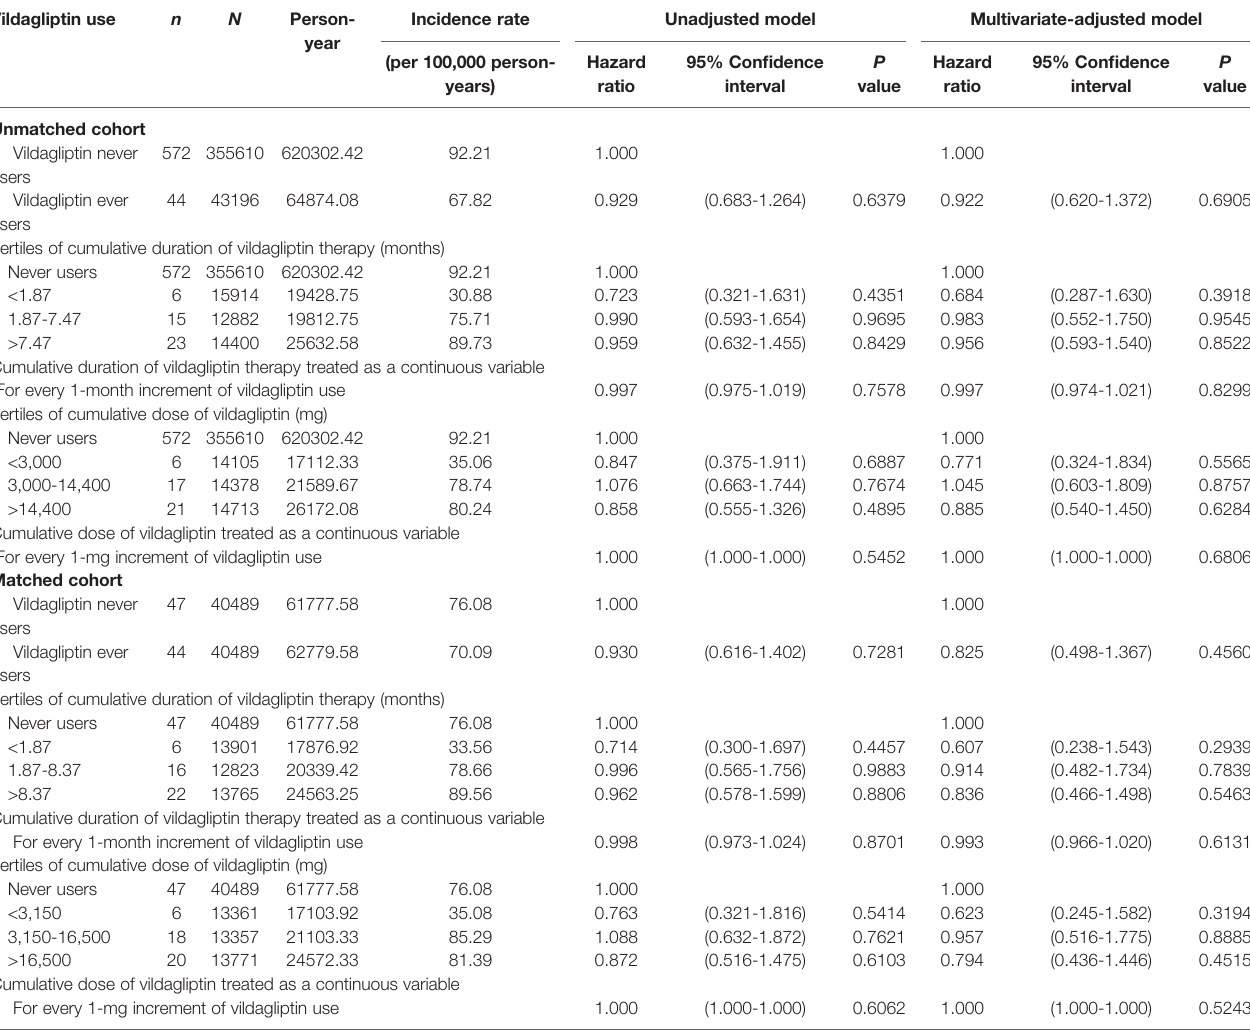
TABLE 2 | Incidence rates and hazard ratios of dementia by vildagliptin